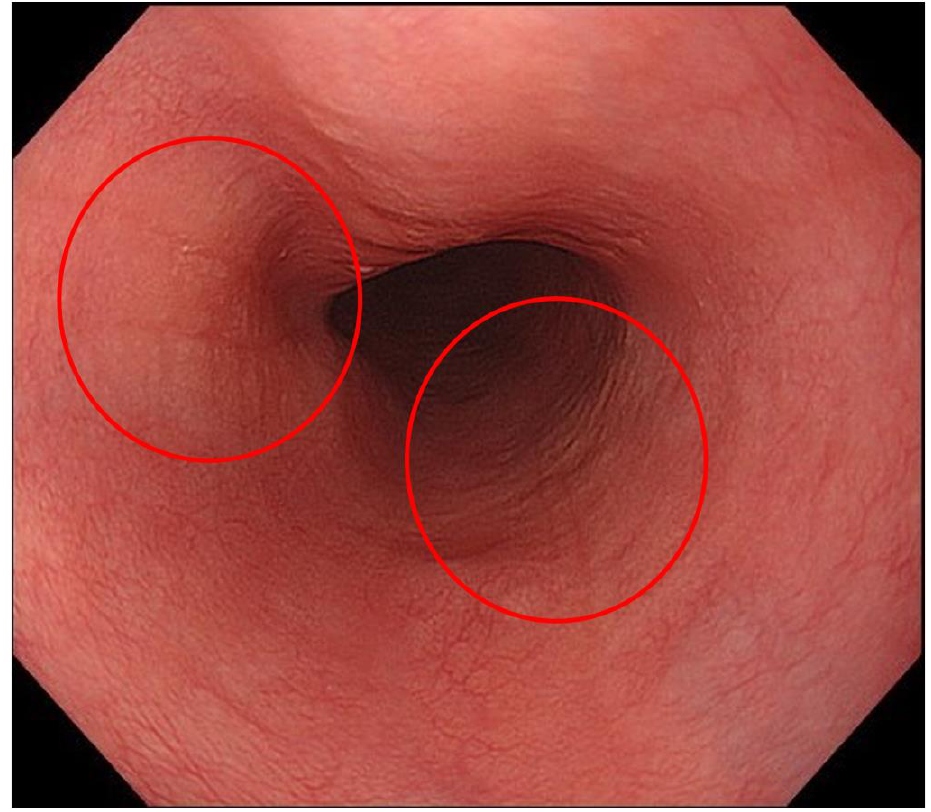
Figure 7. A case in which furrows were seen focally. Since furrows were seen focally (red circles), these findings might not be detected in white light imaging.